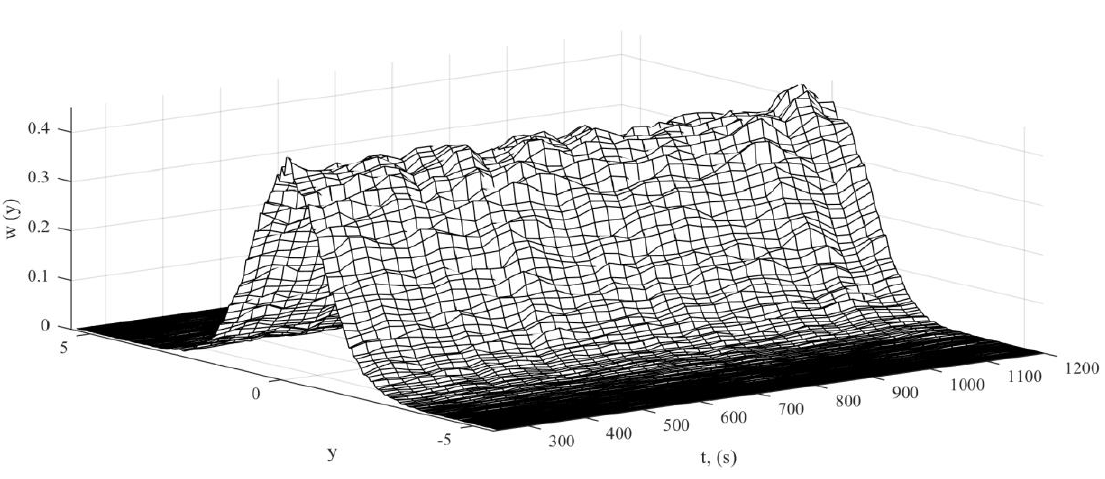
Figure 4. Underwater noise signal after AGC and normalization by the level. Time dependence of the smoothed histograms for T = 10 s.